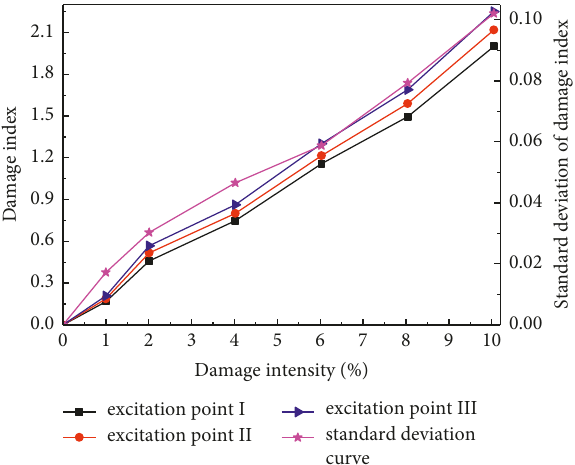
Figure 12: Curves of the damage intensity and damage index under different excitation points (point 4).